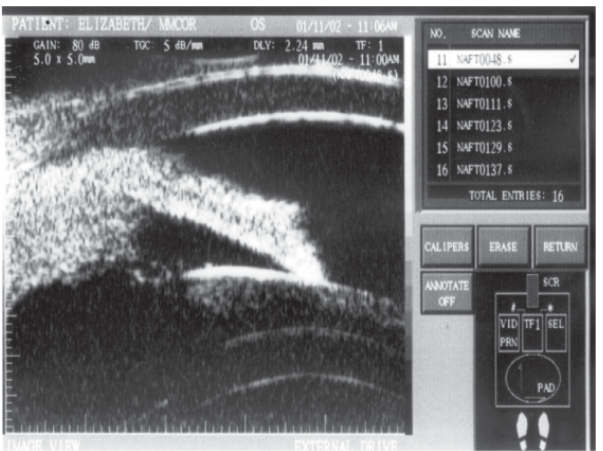
Figure 3 - Case 3 ultrasound biomicroscopy (UBM): increase in the thickness of the ciliary body, in a solid form and with variable echogenicity, with impairment of the root of the